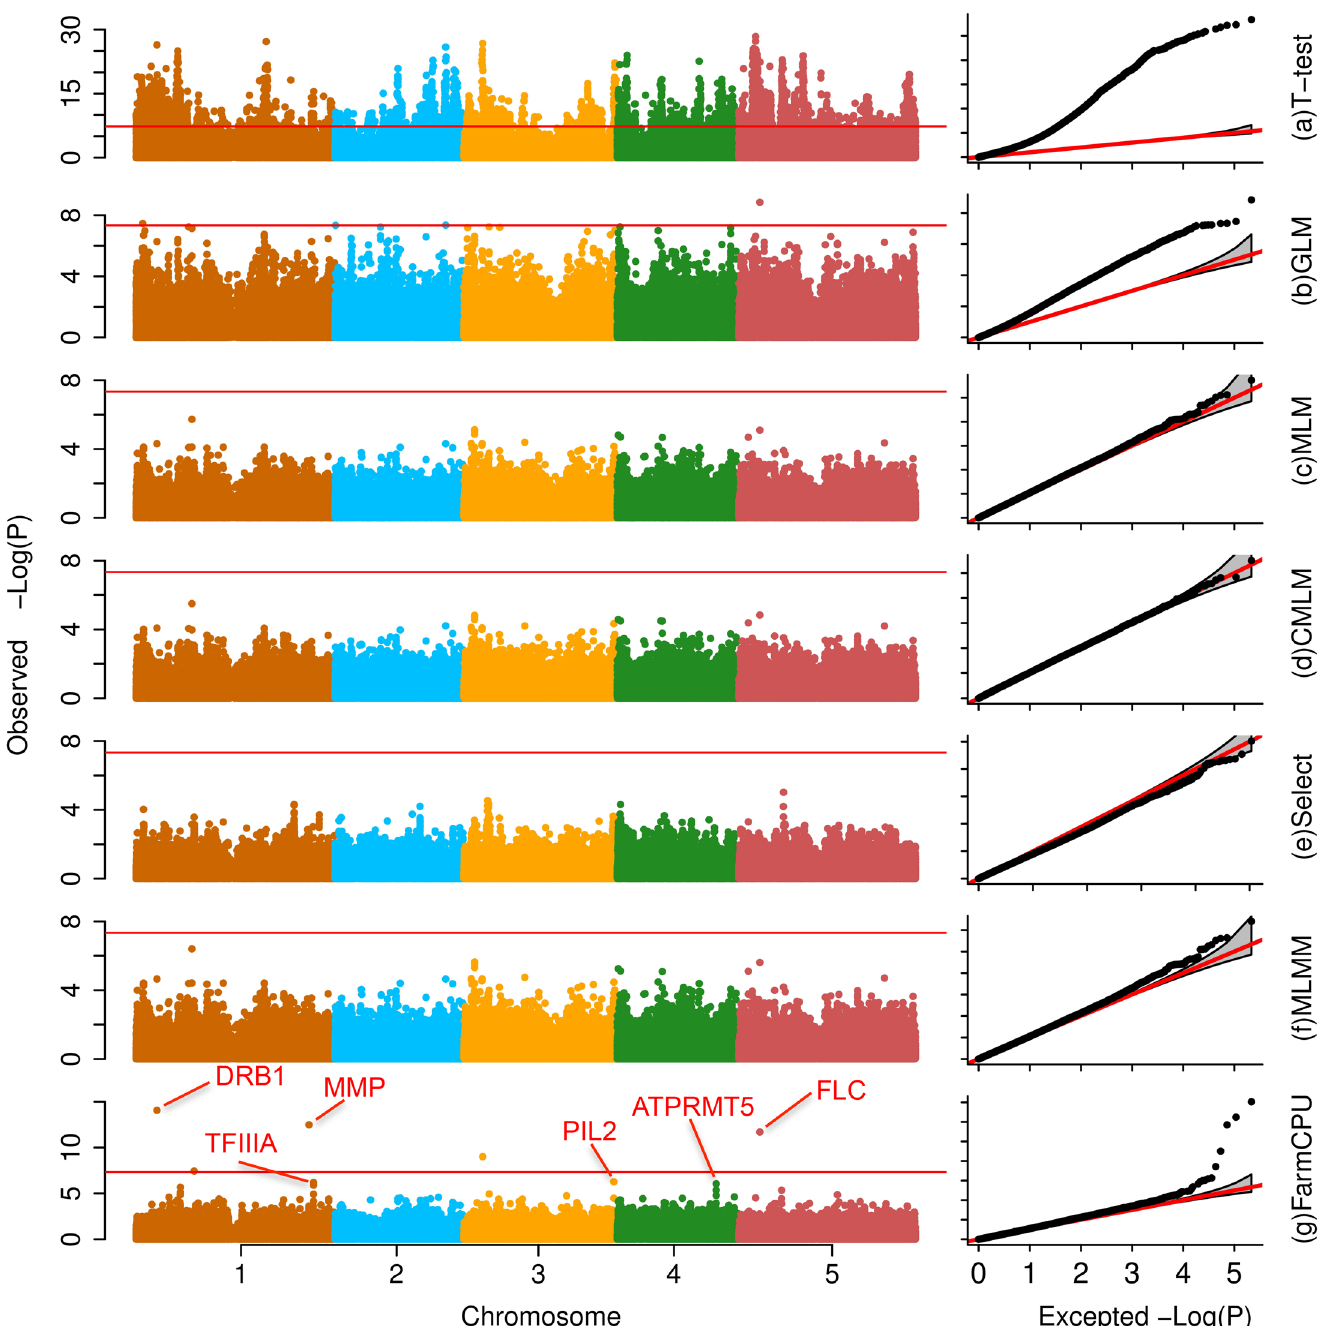
Fig 3. Association studies of flowering time in Arabidopsis thaliana . The flowering time at 16°C was measured on 199 Arabidopsis thaliana individuals genotyped with 250,000 SNPs. Seven statistical methods were employed to conduct the association studies: (a) t-test (na ï ve method), which tests the additive genetic effect of markers, one marker at a time, with the marker as the only explanatory variable; (b) GLM; (c) MLM; (d) CMLM; (e) FaST-LMM-Select; (f) MLMM; and (g) FarmCPU. All methods, except the t-test, MLMM and FarmCPU, included the first three PCs derived from the genetic markers as covariates. FarmCPU identified five associated SNPs after Bonferroni multiple test correction, including three within a distance of 50,000 base pairs to known genes such as FLC. MLMM identified two associated SNPs after Bonferroni multiple test correction, and overlapped with the five associated SNPs from FarmCPU results. With all other methods, these genes are indistinguishable from the background noise.